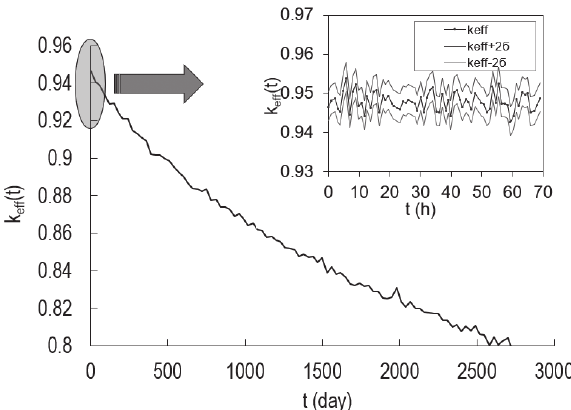
Figure 6. Dependence of the effective multiplication factor on the operating time of the fusion-fission